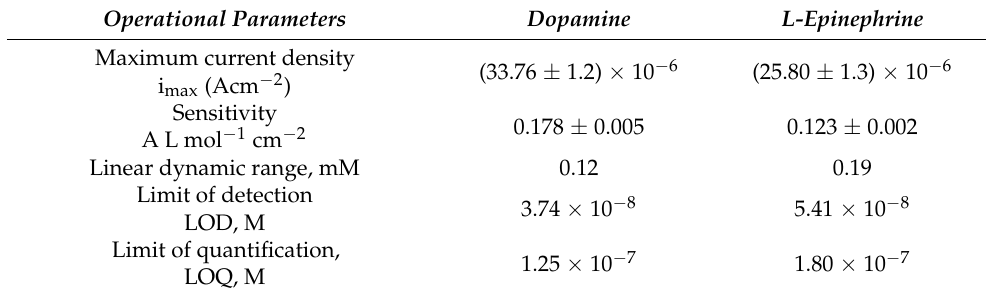
Table 2. Operational parameters of laccase biosensor in dopamine and L-epinephrine present as substrates; operating potential − 0.1 V (vs. Ag|AgCl, sat. KCl); temperature: 20 ± 1 ◦ C.